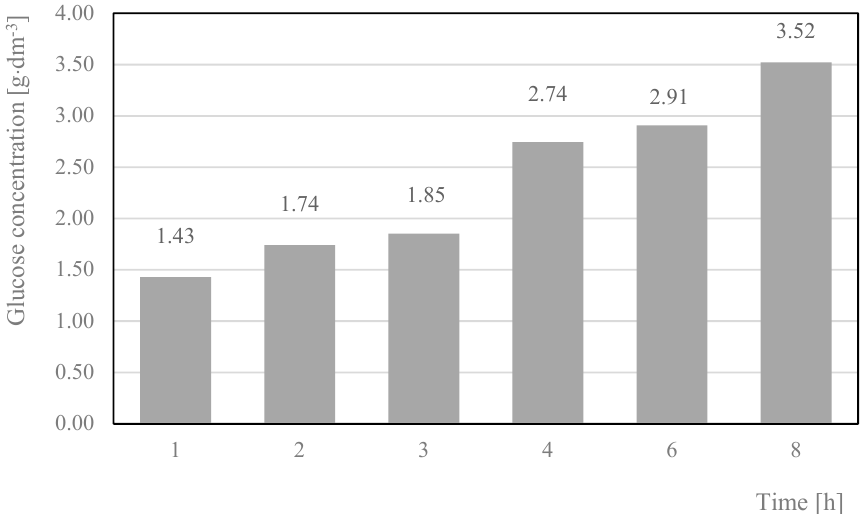
Figure 10. Glucose concentration in hydrolysates, depending on the time of the process. Reaction conditions: 120 °C, 2% H 2 SO 4 . Glucose concentrations were the arithmetic means of the results obtained in the three hydrolysis processes with the standard deviations: 1.43 ± 0.16; 1.739 ± 0.16; 1.85 ± 0.15; 2.74 ± 0.19; 2.91 ± 0.24; 3.52 ± 0.33.